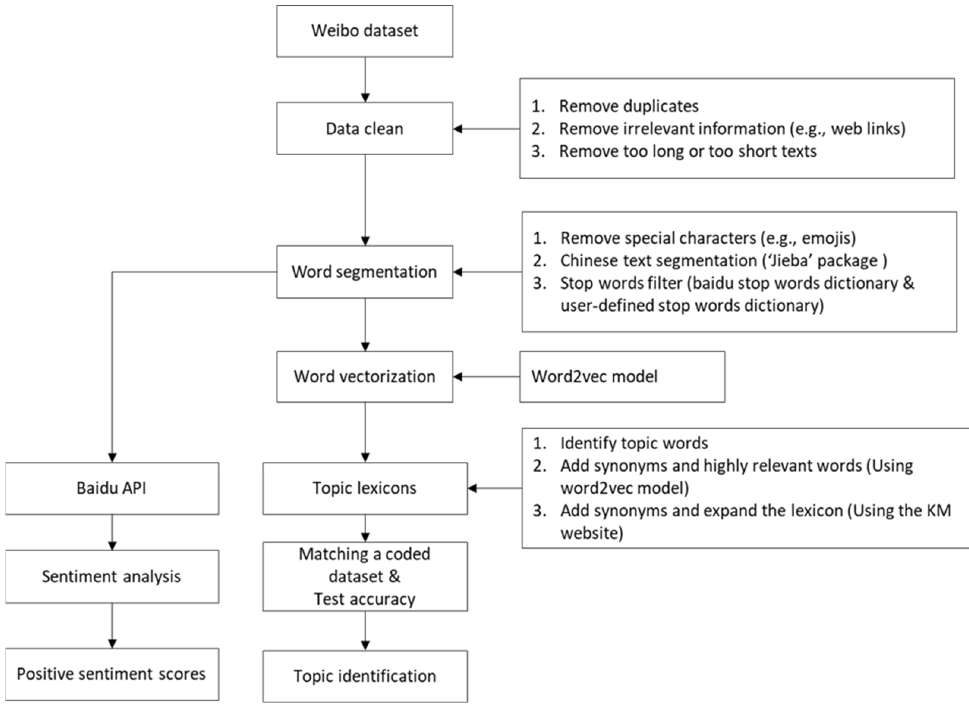
Figure 1. The flow of data